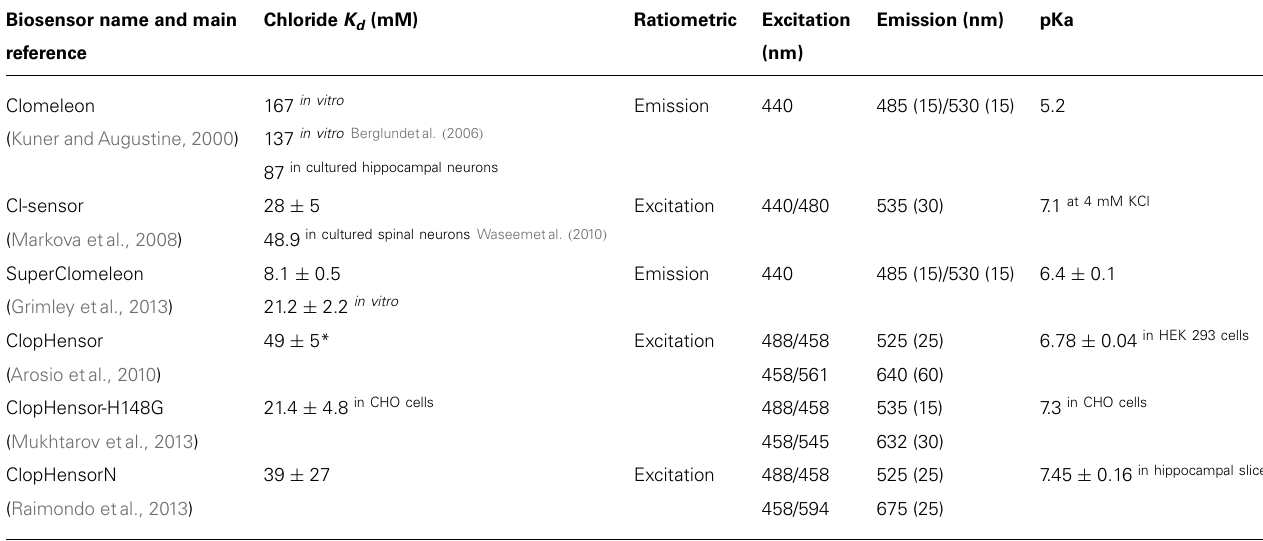
Table 2 | Properties of ratiometric